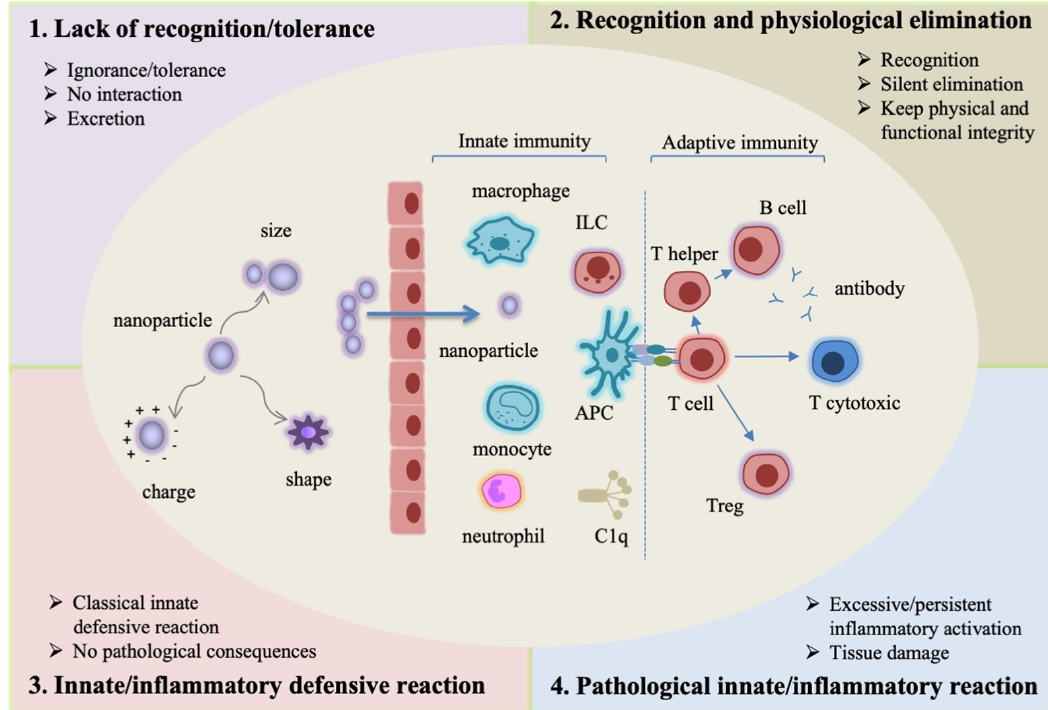
Figure 1. The four possible outcomes of nanomaterial–immune system interaction. The reaction of innate immune cells to ENMs depends on the physical–chemical characteristics of the material and on the tissue microenvironmental conditions in which it occurs. Innate immunity is the first system involved in the interaction and is later responsible for initiating adaptive immune responses. The four possible outcomes are ( 1 ) Ignorance/tolerance, ( 2 ) Recognition and silent elimination, ( 3 ) Innate defensive reaction, ( 4 ) Pathological reaction. The latter event is very rare.